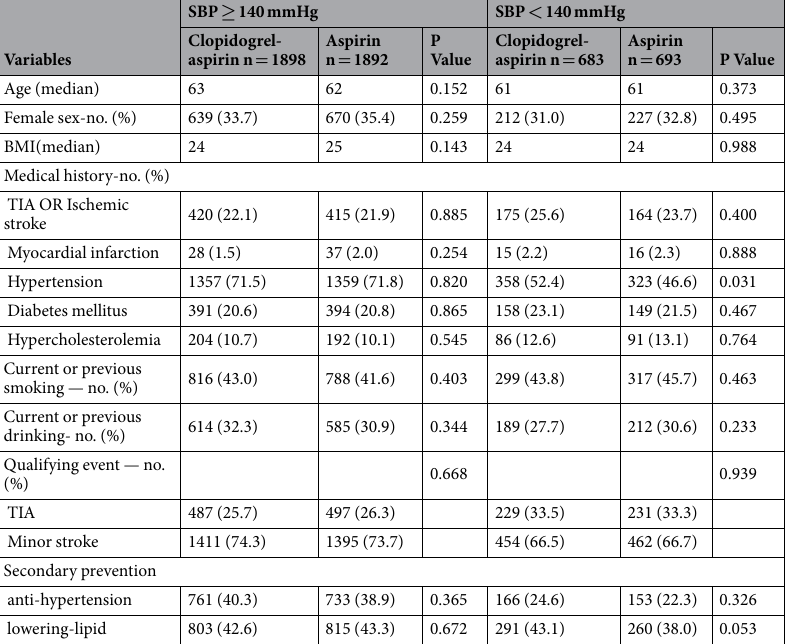
Table 1. Baseline characteristics of patients with different SBP level. There were four patients missing the systolic blood pressure values. Abbreviations: BMI = body mass index; DBP = diastolic blood pressure; SD = standard deviation, TIA = transient ischemic attack.